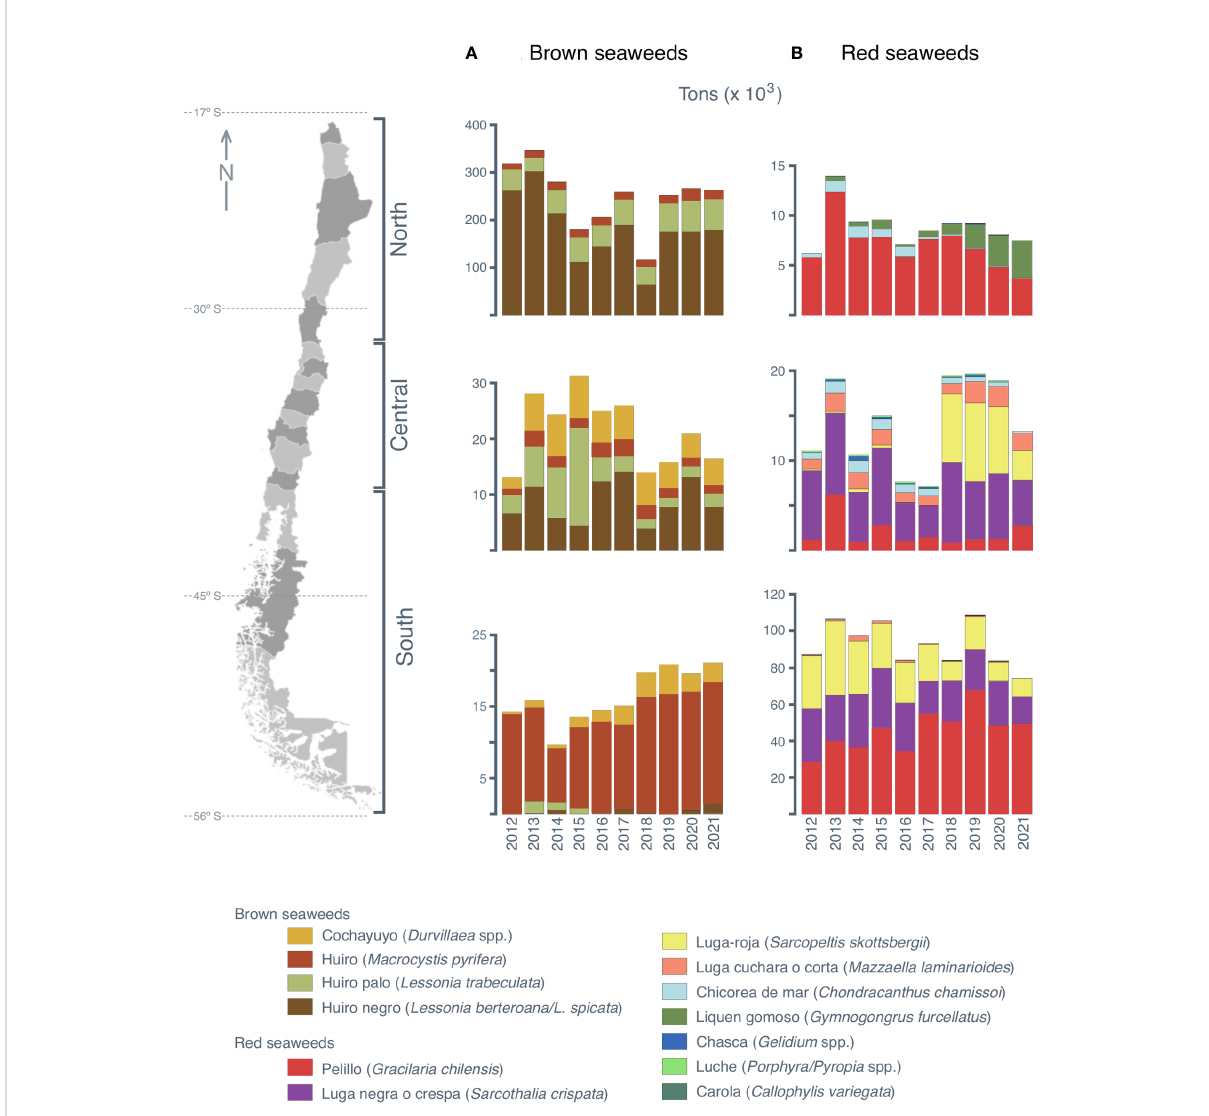
FIGURE 1 Annual landings (2012 – 2021; SERNAPESCA, 2022) of (A) brown seaweeds and (B) red seaweeds in three geopolitical areas along the coast of